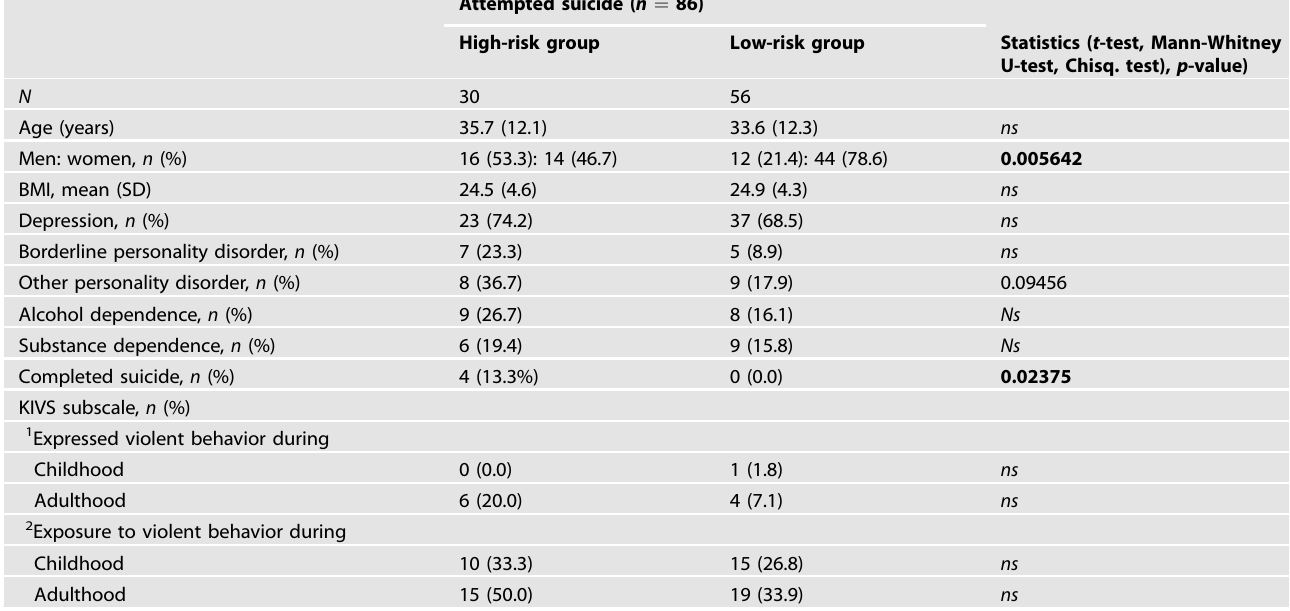
Table 1. Characteristics of